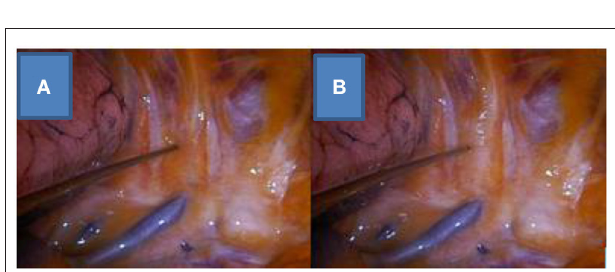
FIGURE 2 | Internal paravertebral/intercostal nerve block on the right side, before (A) and after (B) the local